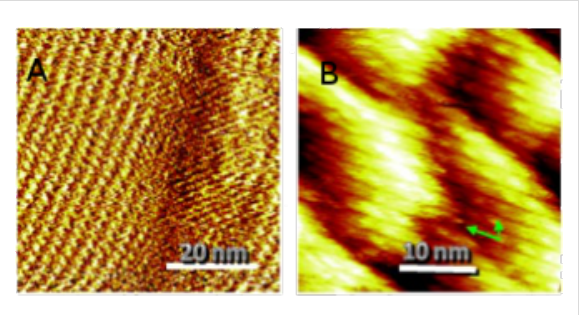
Figure 7: Self-assembly on graphene. Drift-corrected STM images obtained in air on a monolayer graphene substrate grown by chemical vapor deposition on a polycrystalline copper foil at the interface between this substrate and a 10 − 4 M solution of Janus tectons in phenyloctane. (A) 58 × 58 nm, set point I T = 20 pA, sample bias V B = − 950 mV, (B) 34 × 34 nm, I T = 13 pA, V B = − 950 mV. A unit cell corresponding to the lattice formed on HOPG ( a = 3.84 nm, b = 2.08 nm, and α = 64°) is highlighted in (B) by green arrows. Figure adapted with permission from [25], copyright 2014 Wiley-VCH Verlag GmbH &